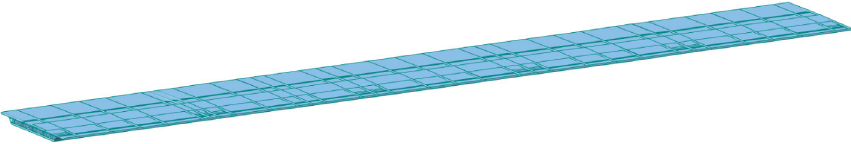
Figure 5: Steel-concrete composite bridge structure model. Table 2: Temperature data measured on June 7, 2021 (unit: ° C).